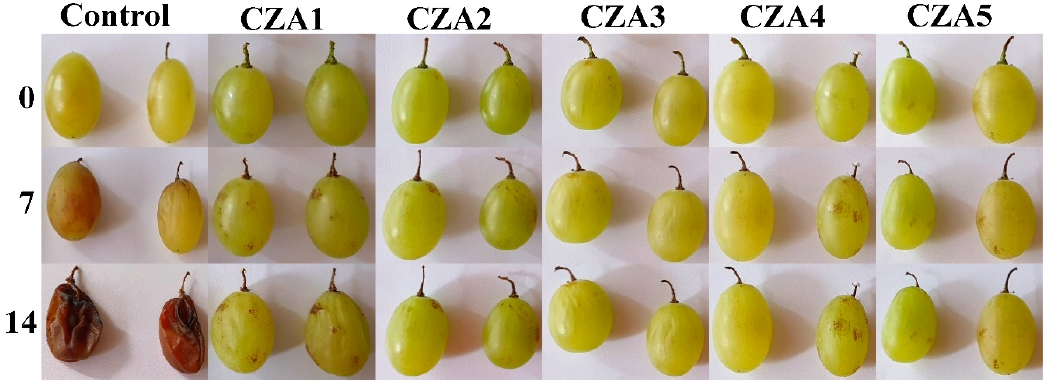
Figure 18. Visual appearance of white grapes packaged in control (polyethylene film) and CZA1–CZA5 films, after 0, 7, and 14 days storage at 30 °C and 60% relative humidity.